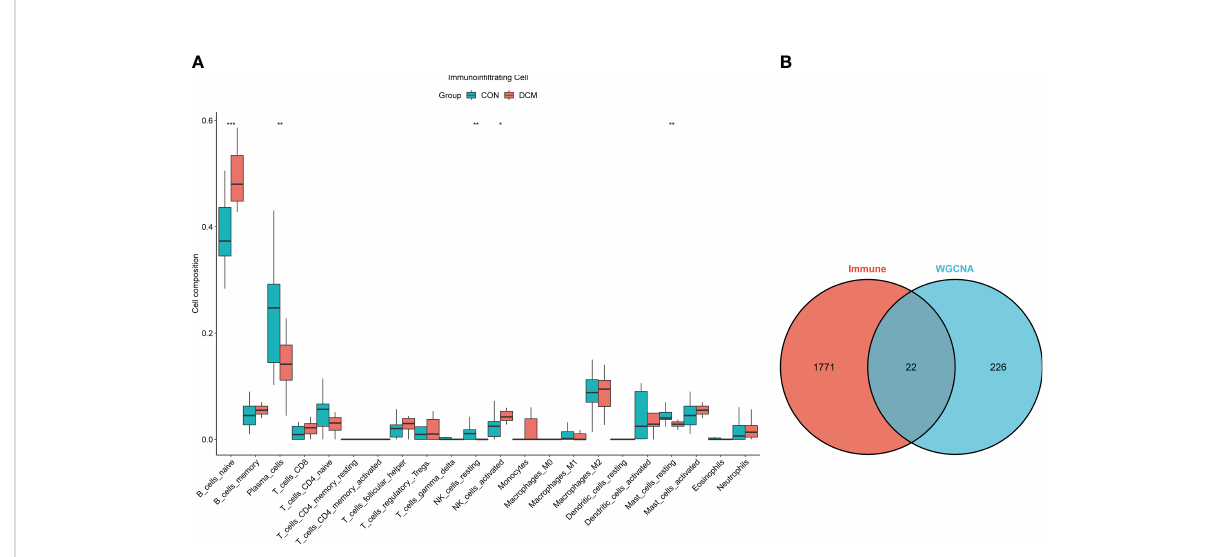
FIGURE 3 Immune in fi ltration analysis and intersection dataset. (A) Boxplot diagram of proportions of 22 types of immune cells. (B) Venn diagram of intersection of black modules and immune genes. * means p value <0.05; ** means p value <0.01; *** means p value <0.001.